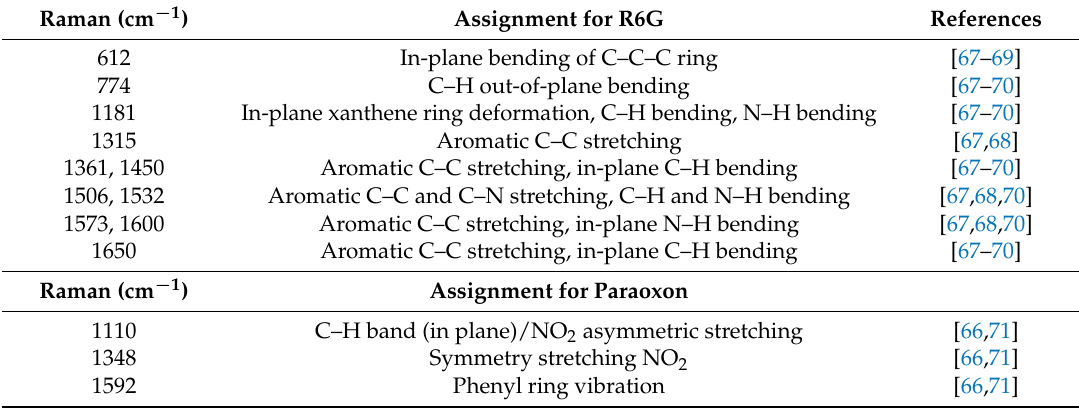
Table 1. Raman mode assignments for R6G and paraoxon, corresponding to Figure